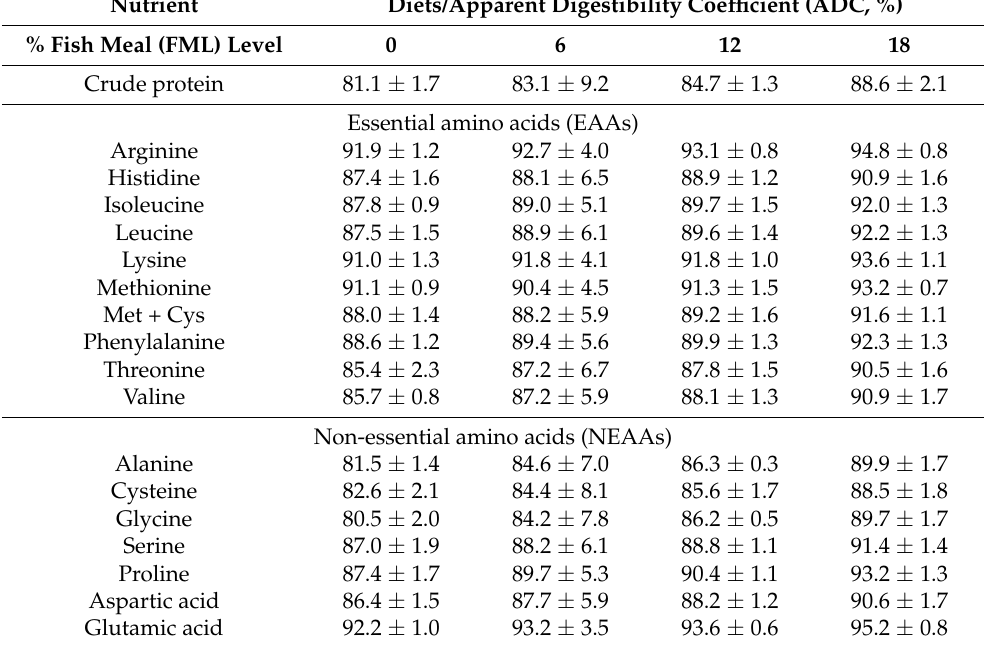
Table 6. Mean ( ± SD) apparent digestibility coefficient (ADC, %) of protein and amino acids in diets containing graded levels of fish